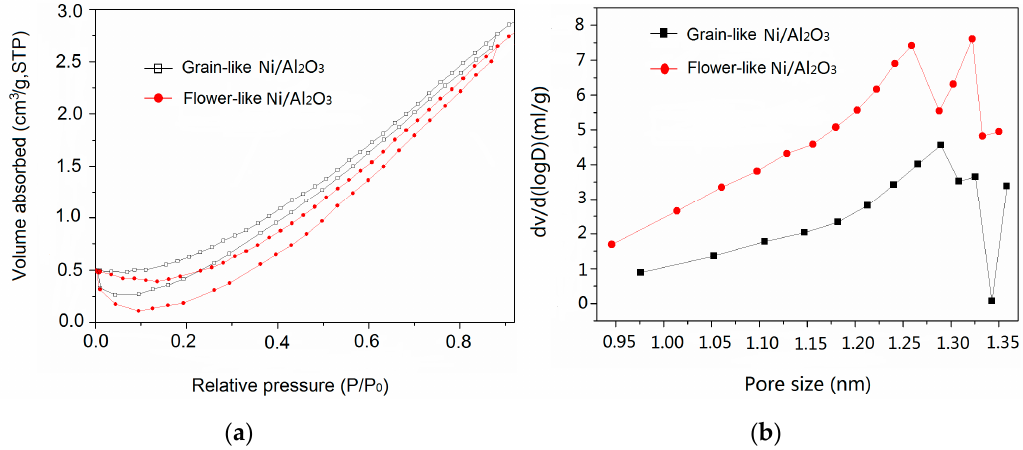
Figure 8. ( a ) Nitrogen adsorption–desorption isotherms and ( b ) pore size distributions of grain-like and flower-like Ni/Al 2 O 3 /Ni film.